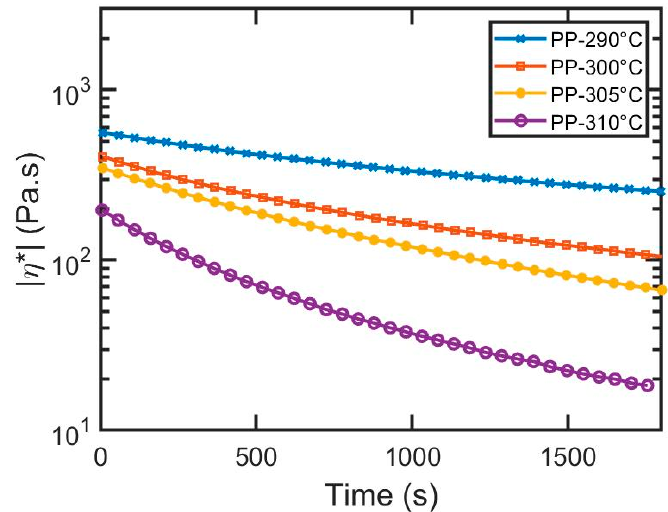
Figure 5. Thermal stability of polypropylene at various temperatures (isothermal time sweep mode).